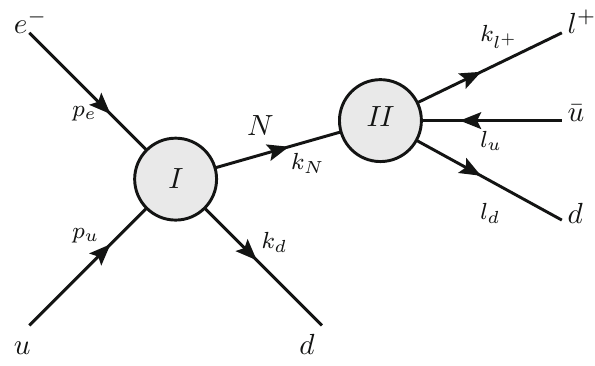
Fig. 1 Process ep → l + + 3jets + X with N decaying according to Refs.